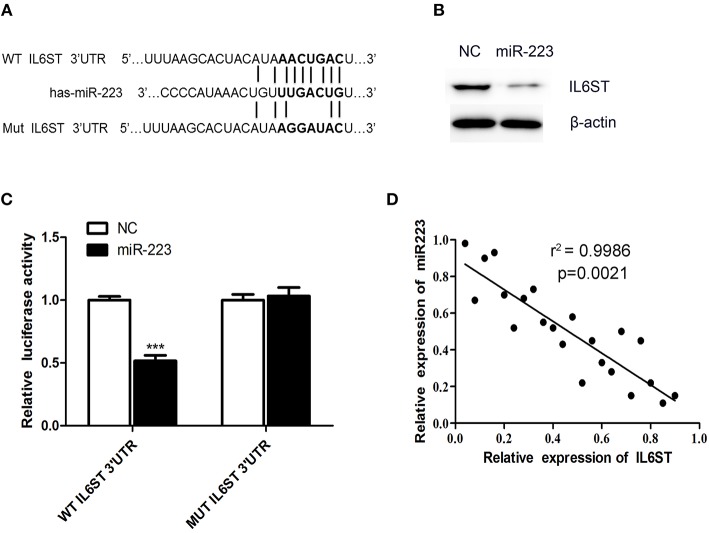
IL6ST is a target gene of miR-223-3p. (A) Shows the IL6ST 3′UTR-containing reporter construct. Schematic representation of the miR-223-3p sequence, putative miR-223-3p targeting site in the 3′UTR of IL6ST, and the generated mutant IL6ST 3′UTR. (B) The western blot analysis shows that the cells transfected with miR-223 showed lower expression of IL6ST protein. (C) Luciferase reporter assay indicates the inhibitory effect that miR-223 has on the luciferase activity of IL6ST-3′UTR. (D) Correlation of the expression of IL6ST to that of miR-223-3p in KD samples using simple linear regression analysis. ***P < 0.001.